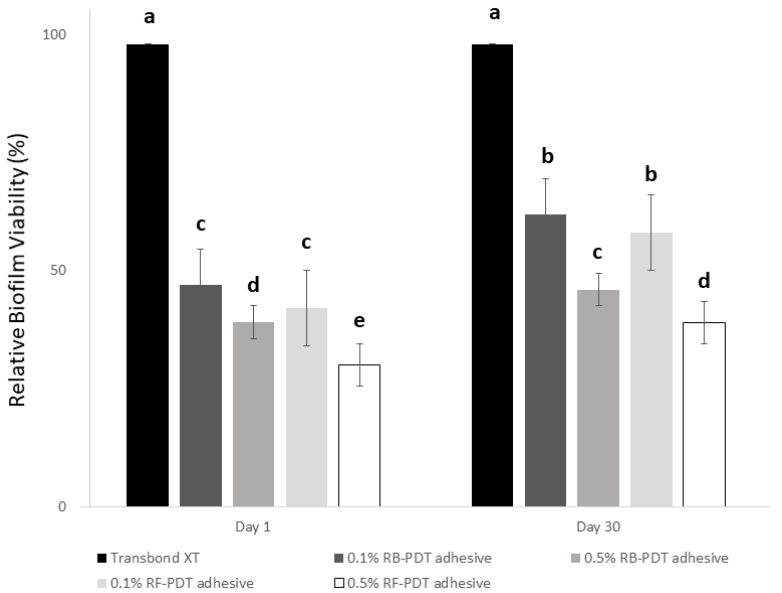
Figure 4. The relative biofilm viability expressed in percentage after Day 1 of incubation of S. mutans on experimental adhesives of 10 groups (5 for Day 1 groups, and 5 for Day 30 groups). The data are expressed as means and SD, groups with the dissimilar letters are statistically significant ( p < 0.05).